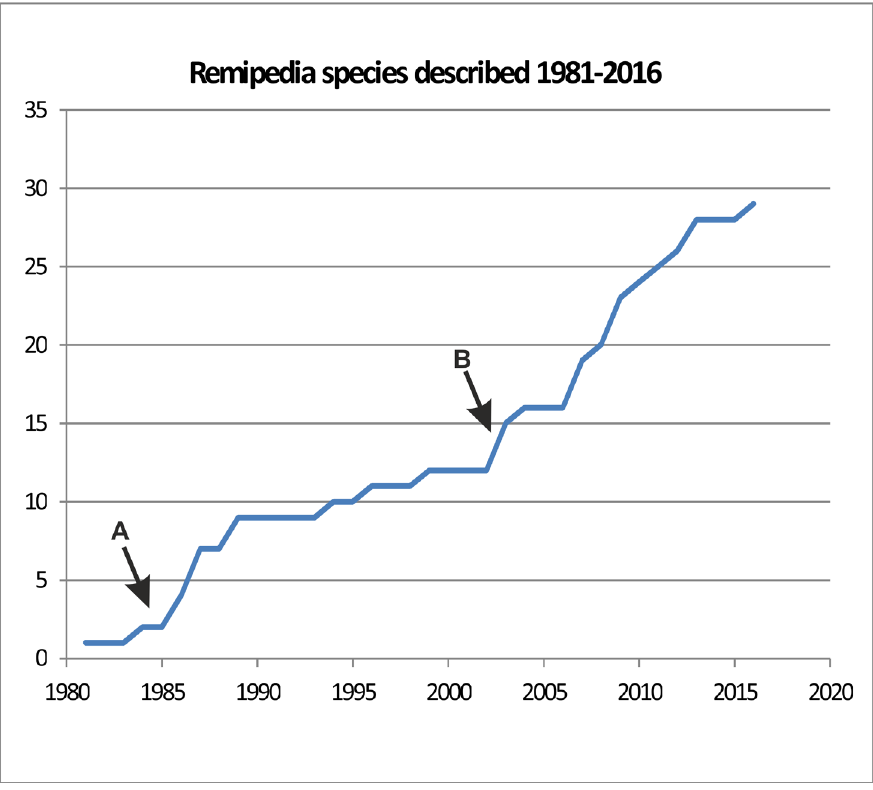
Fig. 1. Described species of Remipedia as accumulated over time (1981 to 2016). A total number of 29 species is known, including Xibalbanus cozumelensis sp. nov. Arrows indicate the onset of significant collecting activities mainly organized by J. Yager in the 1980s (A) and T.M. Iliffe in the 2000s (B).